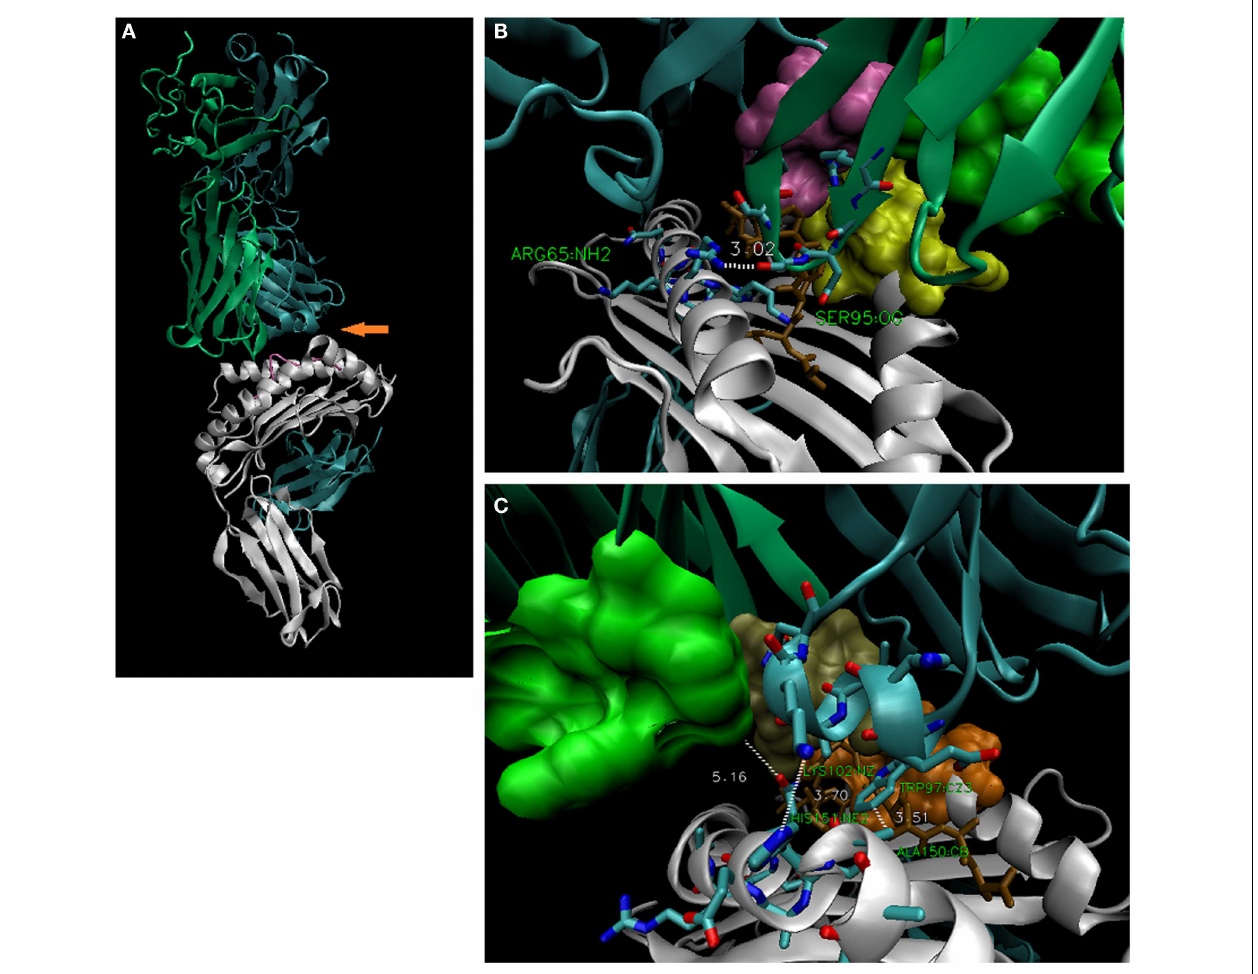
2VLR, this seems an alternate strategy to the same distance of TCR contacts with the polymorphic a.a. 151–158 subregion. In this case, the interface was directly selected via the rearranged CDR3 β ; in all others, it is indirect via the described geometry; actual frequency for these TCR strategies is not